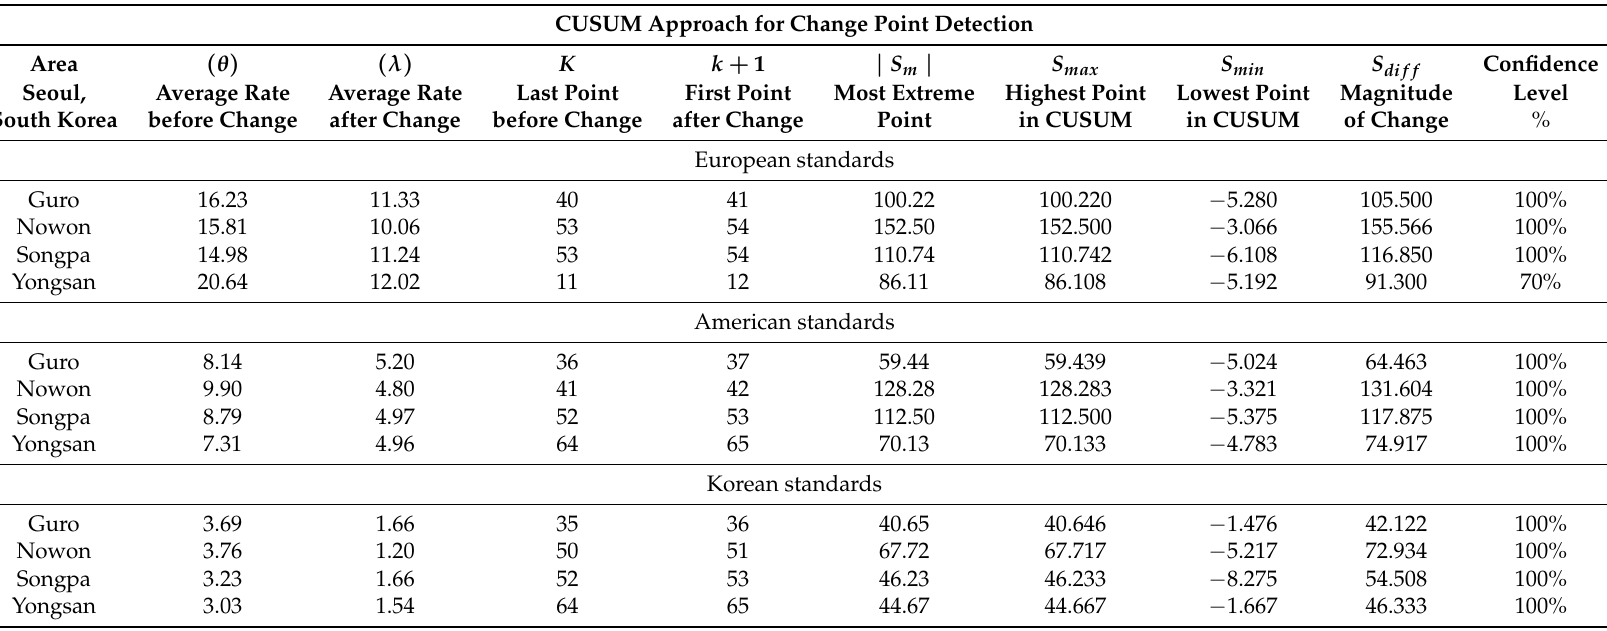
Table 12. PM 2.5 Last point before change ( k ) and First point after change ( k + 1) for European, American and Korean Standards through CUSUM